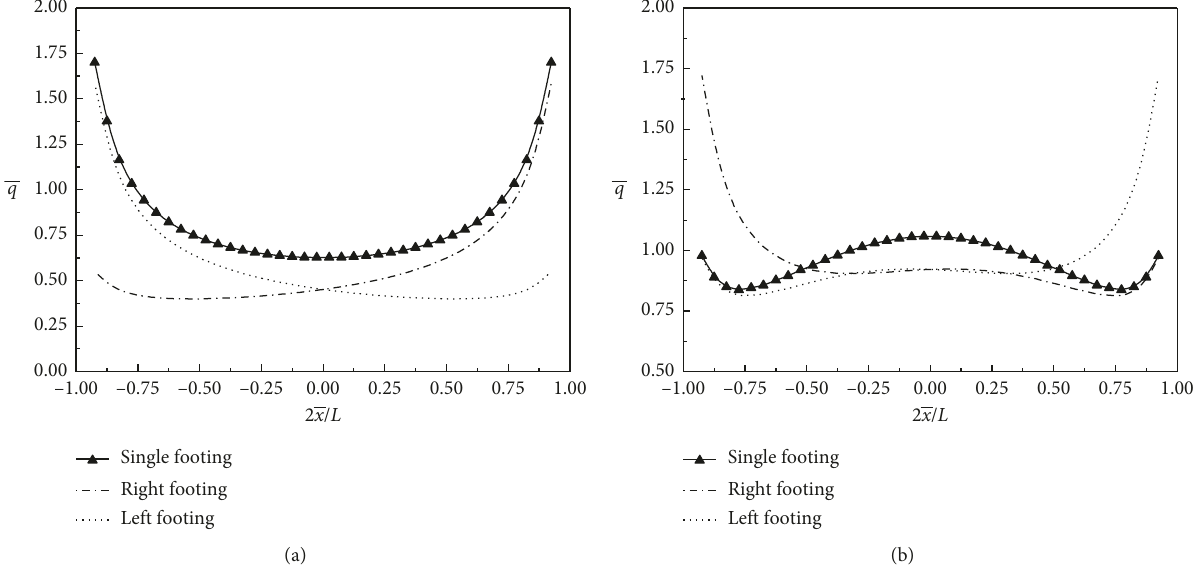
Figure 7: SSSI effect between two strip footings on dynamic contact pressures (footing distance ratio S / L 0.2. (b) a 0 3.0. (a) a 0 (cid:31) (cid:31)